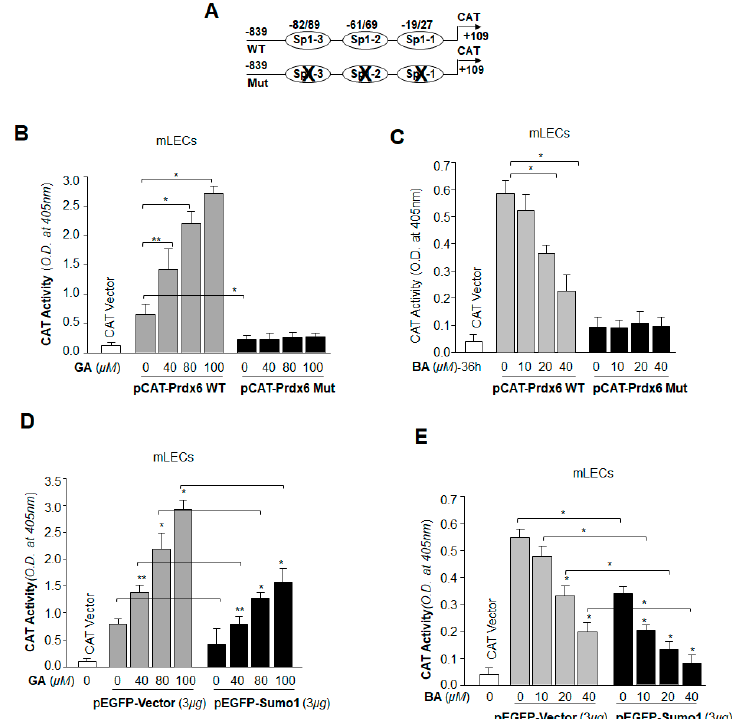
Figure 10. Prdx6 transcription in LECs was significantly increased by Sumoylation inhibitor GA and reduced by Sumoylation agonist BA. ( A ) LECs were transfected with Prdx6 promoter linked to chloramphenicol acetyltransferase (CAT) reporter plasmid ( − 839/+109) or its mutant (mutated at all Sp1 sites). Transfected cells were treated 48h later, with different concentrations of GA ( B ) for 6 h or BA ( C ) for 36 h as shown. Protein was extracted and CAT-ELISA was performed as stated in Materials and Methods. GA significantly enhanced Prdx6 promoter activity ( B , gray bars); conversely, BA reduced promoter activity ( C , gray bars) in dose-dependent manner. The data represent the mean ± SD from three independent experiments (** p < 0.05; * p < 0.001). ( D , E ) Effects of GA and BA in modulation of Prdx6 transcription in cells overexpressing Sumo1. LECs were transfected with Prdx6 promoter linked to the CAT vector ( − 839/+109) along with either the pEGFP vector or pEGFP-Sumo1 plasmid as indicated. Cells were treated 48 h later with different concentrations of GA ( D ) for 6 h or BA ( E ) for 36 h. Protein was extracted and CAT-ELISA was performed. In the presence of Sumo1, overall promoter activity was reduced, however, activity was restored by GA ( D , black bars) in comparison to empty vector ( D , gray bars). Conversely, BA treatment reduced overall promoter activity in dose-dependent manner ( E , gray bars), and the promoter activity was further decreased in the presence of Sumo1 ( E , black bars). The data represent the mean ± SD from three independent experiments (** p < 0.05; * p < 0.001).